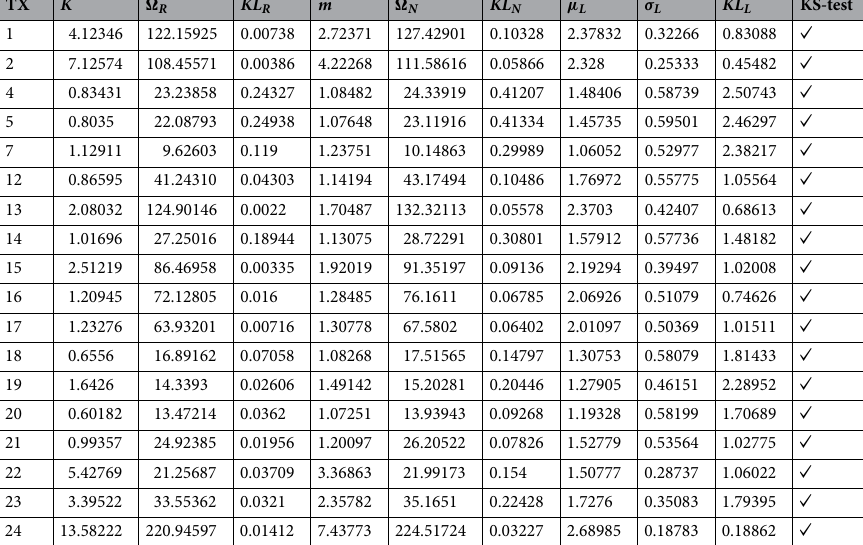
Table 2. Shopping mall links parameters of the Rice, Nakagami-m and Lognormal